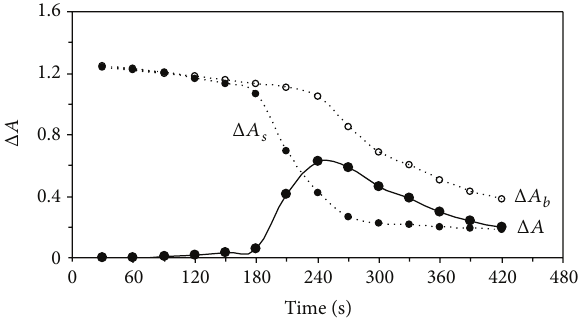
Figure 5: Effect of time on the rate of uninhibited ( Δ𝐴 𝑏 ) and inhib- ited ( Δ𝐴 𝑠 ) reactions and response ( Δ𝐴 ). (Conditions: sulfuric acid, 0.40 mmolL −1 ; thionine, 30.0 𝜇 molL −1 ; dopamine, 3.0 𝜇 gmL −1 ; bromate, 0.50 mmolL −1 ; 30 ∘ C and 30–420 s.)